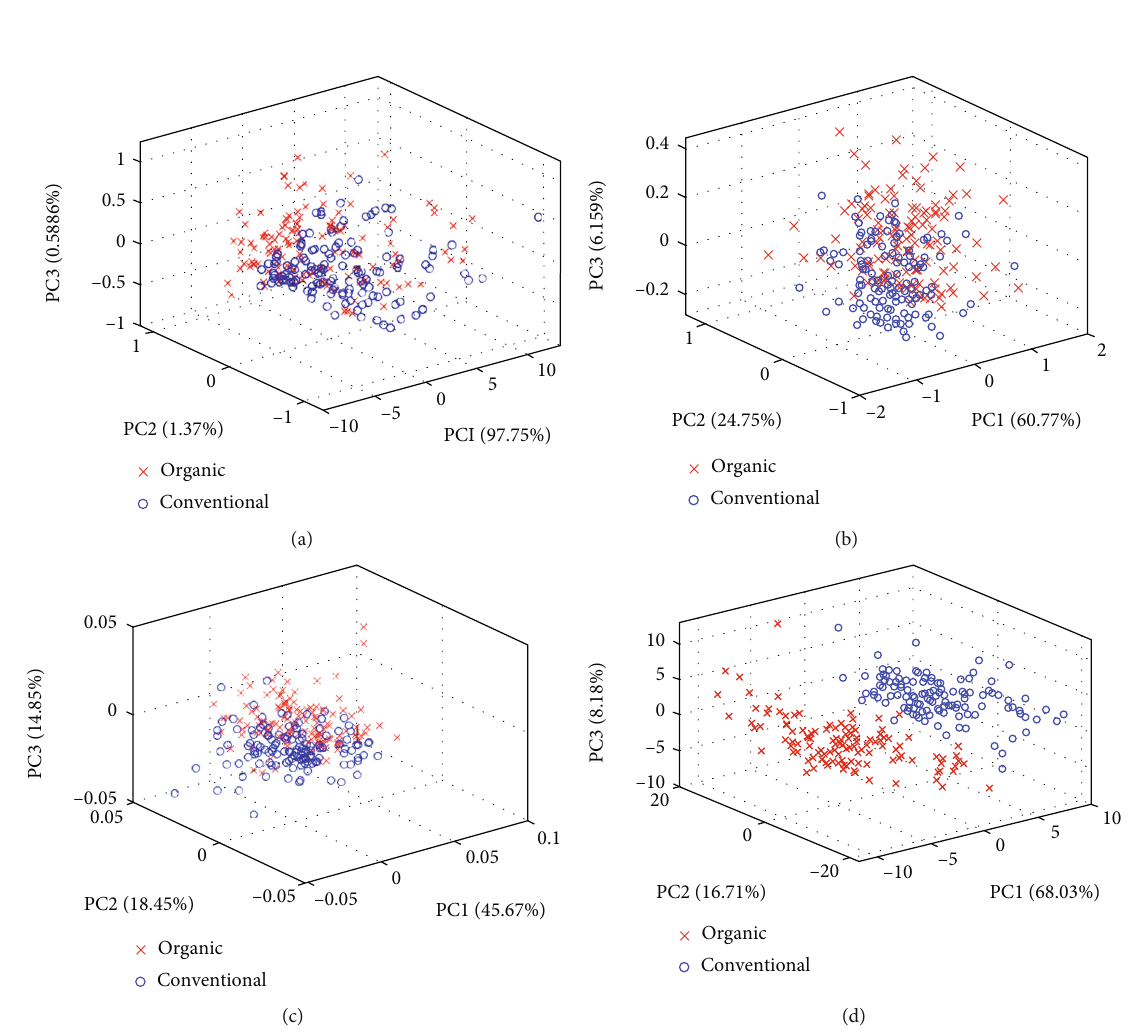
Figure 3: PCA score plot of the fi rst three PCs of organic and conventional cocoa beans: (a) raw, (b) MC, (c) FD, and (d)